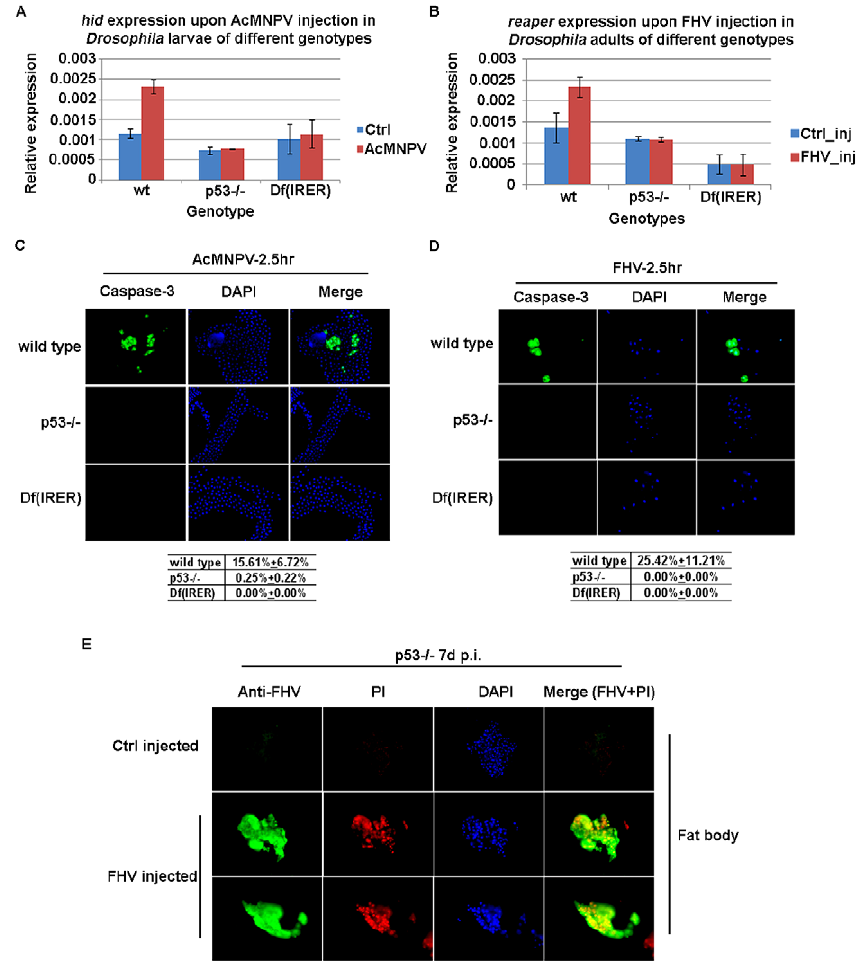
Figure 3. Virus -induced reaper / hid expression and apoptosis requires P53 and IRER. A. The induction of hid following AcMNPV injection was absent in larvae homozygous for a P53 null mutation (p53 2 / 2 ) or a deficiency removing the regulatory region IRER (Df(IRER)). B. Likewise, the induction of reaper following FHV infection also required p53 and IRER. Flies of different genotypes were injected in parallel and sacrificed for total RNA extraction at 1 hr p.i,. C & D. Activated caspases were detected in the fat body cells of D. melanogaster larvae (C) and adults (D) following the infection of AcMNPV or FHV, respectively. The percentage of cells positive for activated caspases in different genotypes is listed in the table below corresponding panel. The induction of apoptotic cells (with activated caspases) was significantly blocked in P53 2 / 2 or IRER deficient flies (p , 0.01 for both). E. Fat body cells in P53 2 / 2 animals became necrotic at 4–7 days p.i.. PI was injected to either control-injected or FHV-injected (2000 PFU/ animal) animals at 7 days p.i. and the animals were sacrificed and fixed 20 min later. The presence of FHV was visualized with an antibody against the FHV capsid protein. The presence of PI staining indicated that the integrity of the cell membrane was compromised in fat body cells infected by FHV. Photos are representative of at least 2 independent